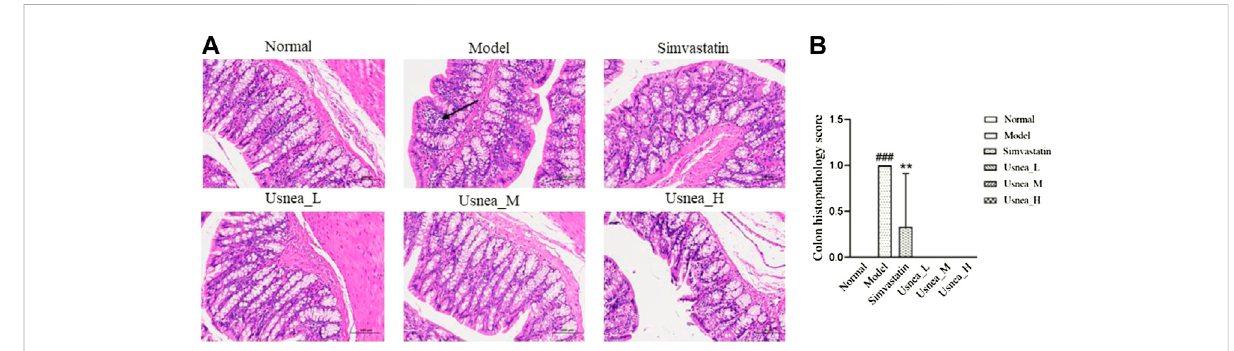
FIGURE 4 (A) Pathological status ofthecolon tissue ineach group ofrats (×200).The mucosal layerof colonic tissue was in fi ltrated byfocal in fl ammatory cells(blackarrow).Valuesareexpressedasmean±SD( n =6pergroup). (B) Colonhistopathologyscore, n =3.Comparedwithnormalgroup, ### p < 0.001; compared with model group, ** p < 0.01, *** p < 0.001.